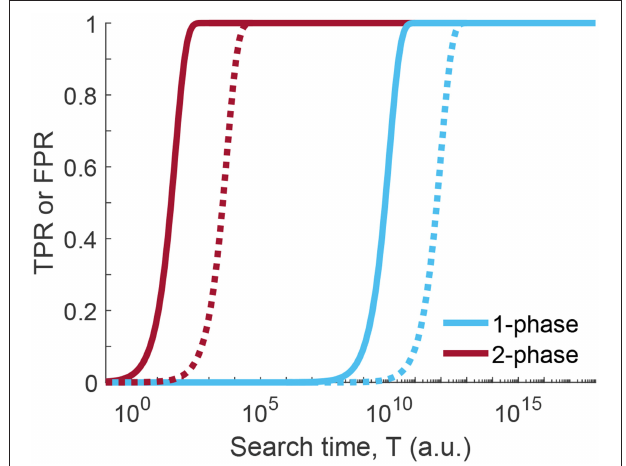
FIGURE 5 | Time comparison of one-phase and two-phase search strategy. True positive rate ( TPR , solid line) or false positive rate ( FPR , dotted line) for one-phase and two-phase search strategy as a function of the search time T (see Equations 16 and 21 of the one-phase and two-phase search, respectively; 1 t = 1). Curves were calculated for p = 10 − 4 , local false positive rates were set to fpr 1 = 10 − 2 and fpr 2 = 10 − 4 for the two-phase search and fpr = fpr 1 · fpr 2 = 10 − 6 for the one-phase search, yielding the same figures of merit for TPR and FPR . For the calculation of the total search time T we